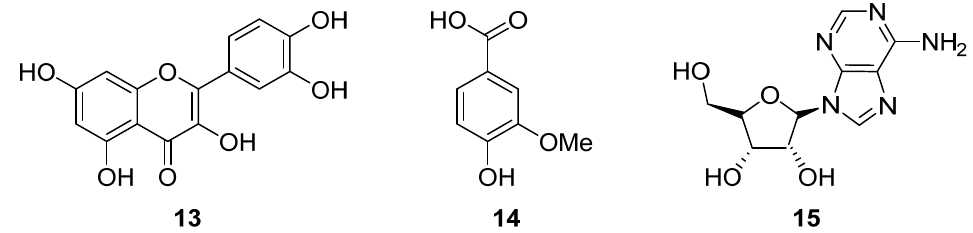
Figure 4. Chemical structures of compounds isolated from the genus Allium . Quercetin ( 13 ), vanillic acid ( 14 ) and adenosine ( 15